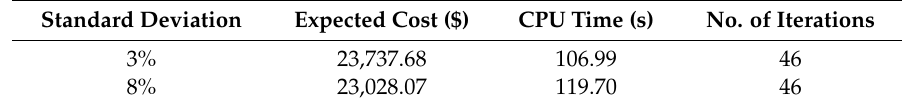
Table 11. Comparisons of results considering different standard deviations of PV power